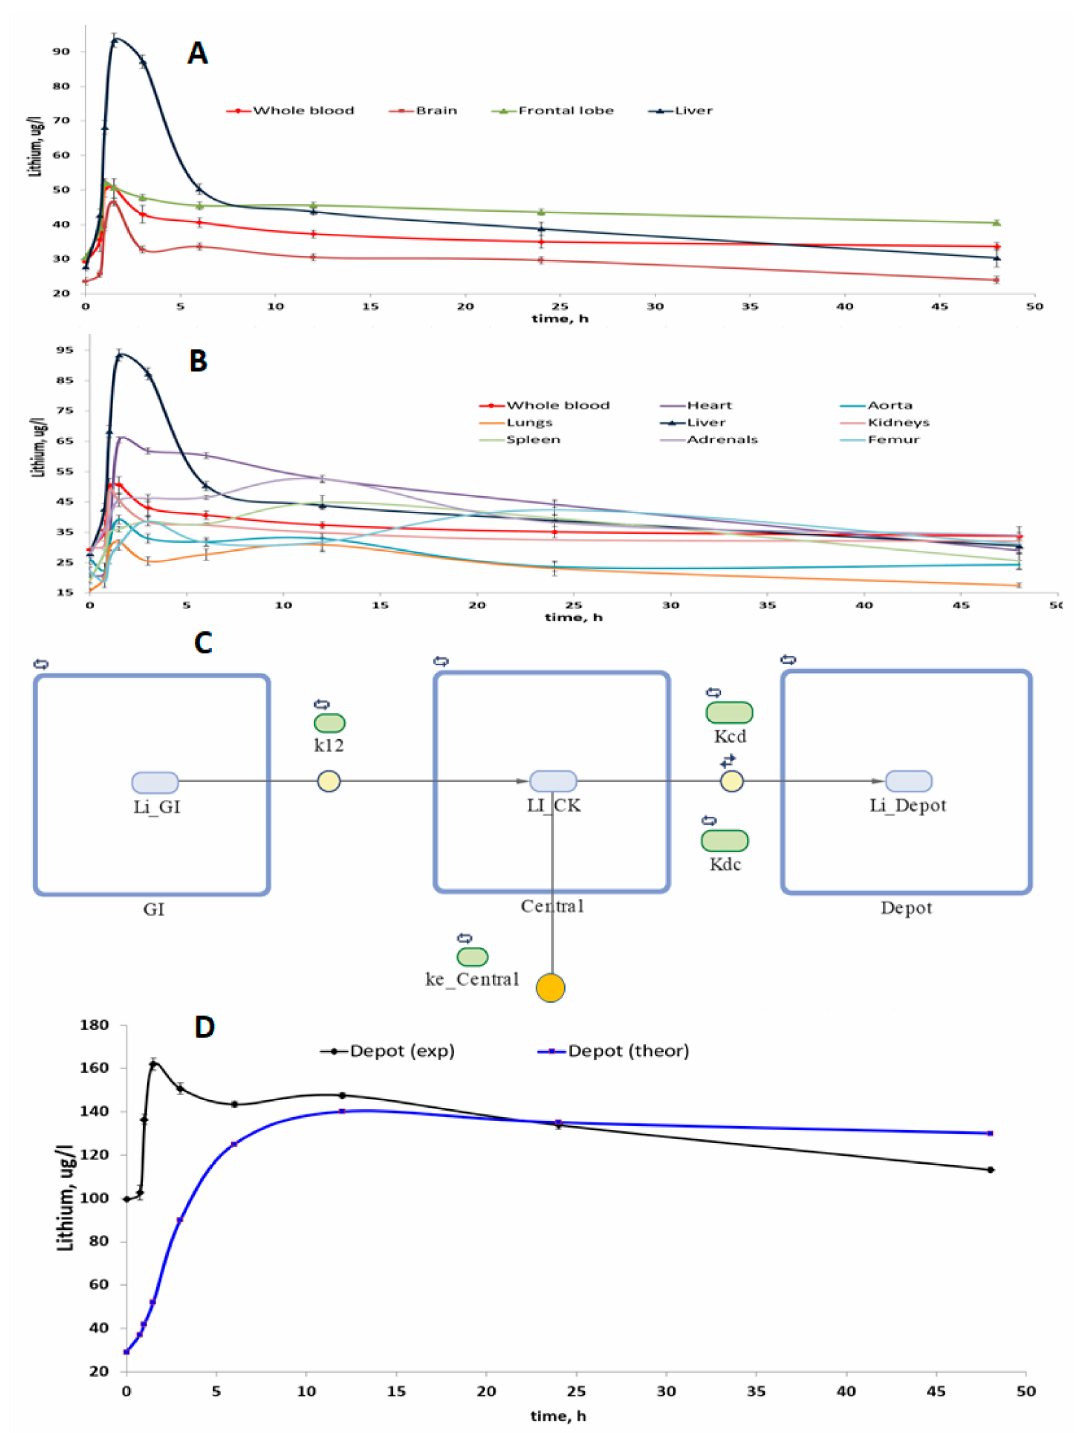
Figure 2. Analysis of lithium biodistribution after a single dose (1000 mg/kg) of lithium ascorbate. ( A ) Pharmacokinetic curves of lithium content in homogenates of brain tissue, whole blood and liver and, ( B ) other organs. ( C ) Three-chamber model of lithium ascorbate pharmacokinetics obtained as a result of multi-chamber pharmacokinetic modeling in MATLAB. The symbols for the corresponding constants are shown in the figure (k12, Kcd, Kdc, Ke_central). ( D ) Dynamics of concentrations in the “depot” of lithium are obtained due to multi-compartmental PK-modeling. The experimental data for the “depot” were obtained by summation of the lithium contents in the brain, aorta, adrenal glands, and